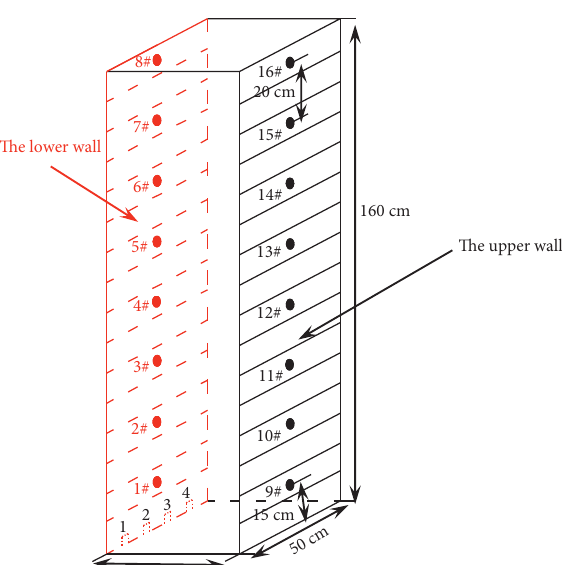
Figure 2: The schematic diagram of the drawing-ore device. Note: 1#, 2#, ... , 16# represent the test channels, and I, II, III, and V represent the drawpoints.